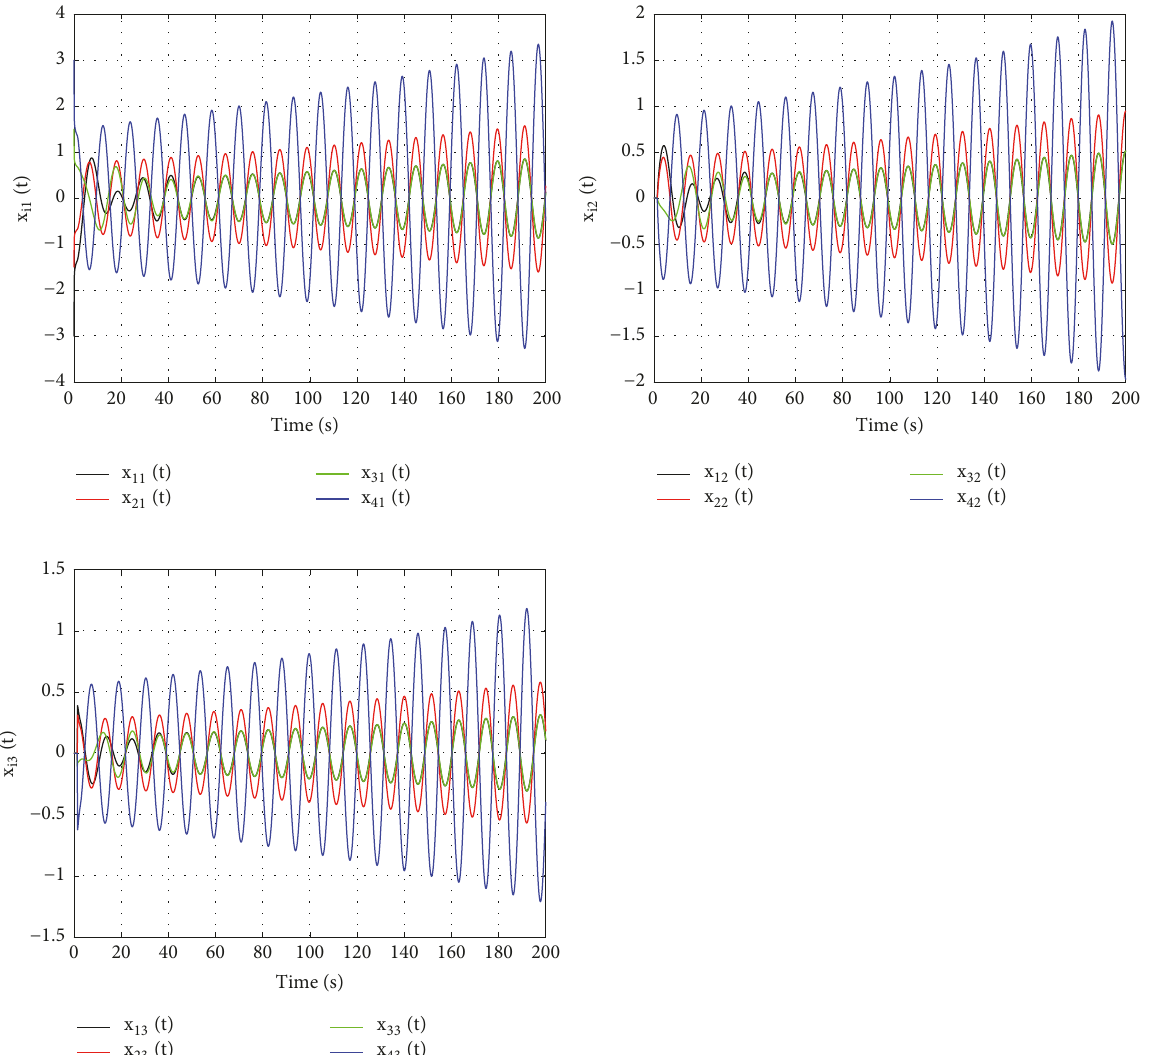
Figure 5: The trajectories of all agents’ states in the FOMAS with triple integral and symmetric time-delays when all 𝜏 𝑚 > 𝜏 in Example 2.